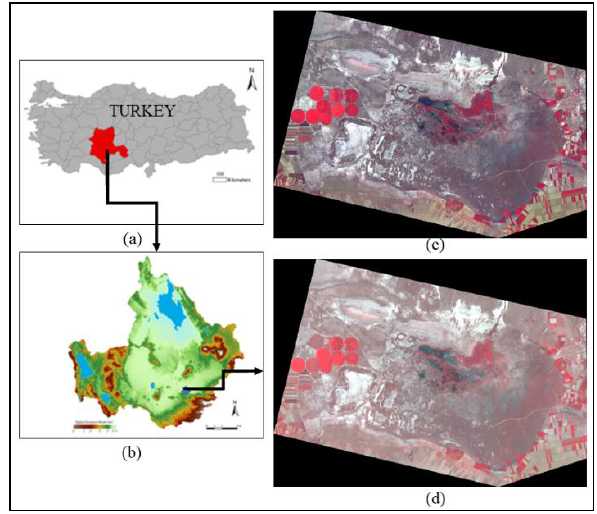
Figure 1. Study area a) Turkey b) Konya Closed Basin c) Worldview-3 Satellite Image d) Planet Satellite